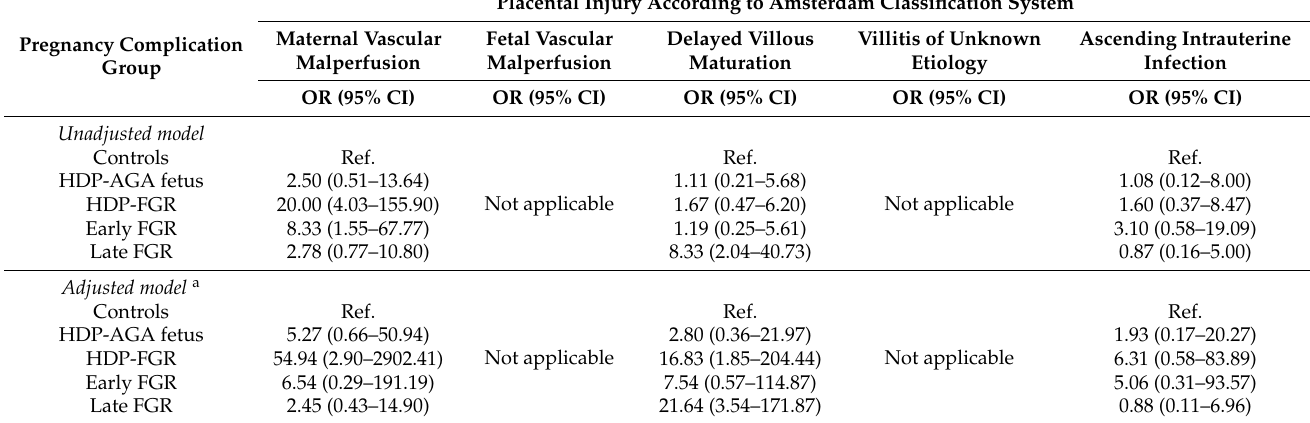
Table 4. Odds ratios (OR) and corresponding 95% confidence intervals (CI) of the risk of placental injury (defined by Amsterdam classification system) according to pregnancy complication